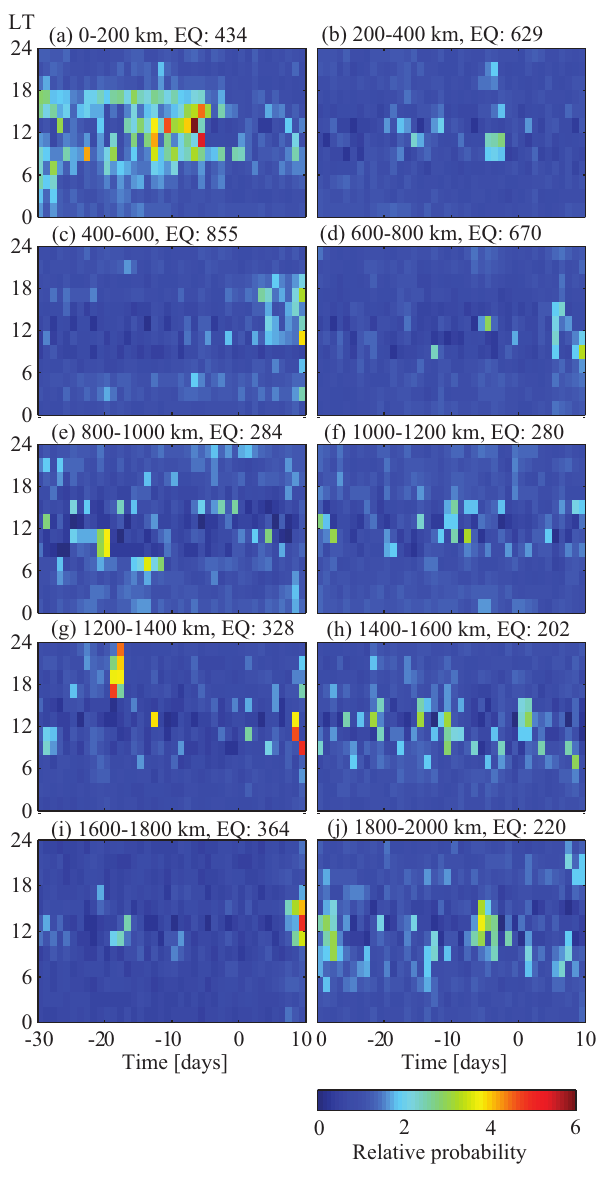
Fig. 6. The effect of distance upon the relative occurrence prob- ability of Pc1 pulsations in relation with earthquakes. Radial dis- tance ranges increase in increments of 200km from 0–200km (a) , to 1800–2000km (j) . The number of earthquakes is indicated in the title of each